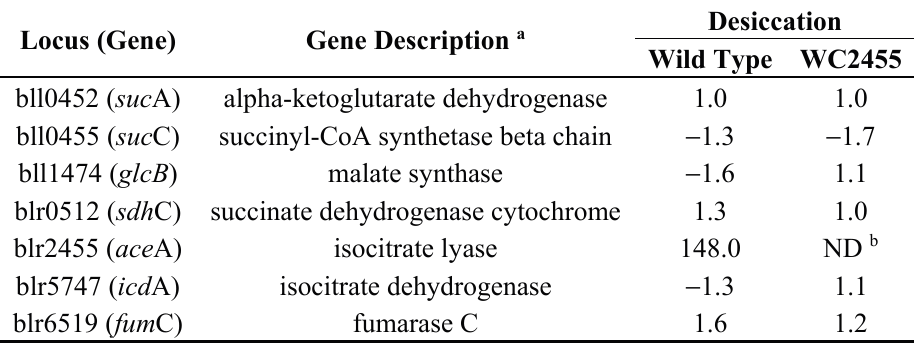
Table 2. Comparison of gene expression level changes against desiccation stress between wild type and WC2455 by qRT-PCR